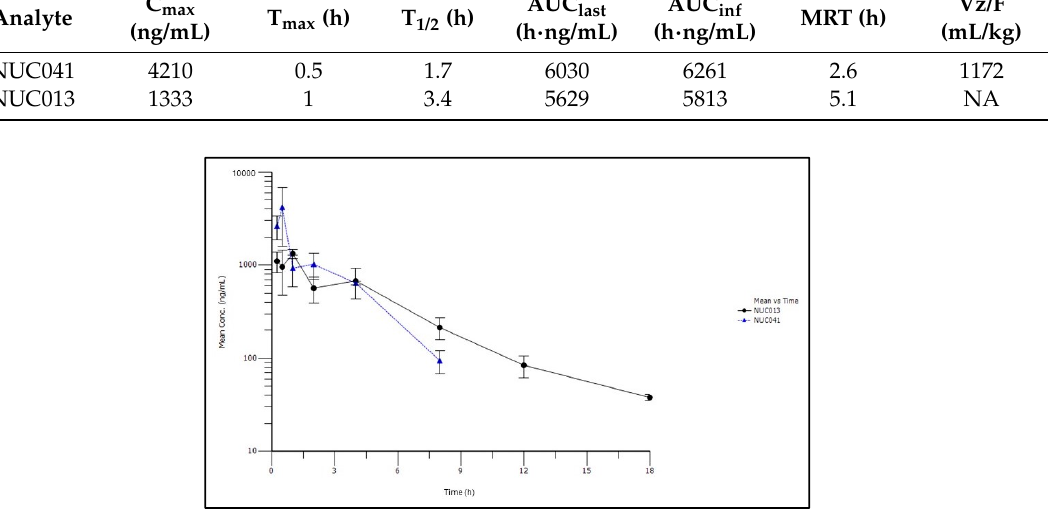
Figure 4. Mean concentrations (±standard deviation) of NUC041 and NUC013 in blood over time following IM administration of NUC041 (3 mg/mouse) in PPD vehicle.